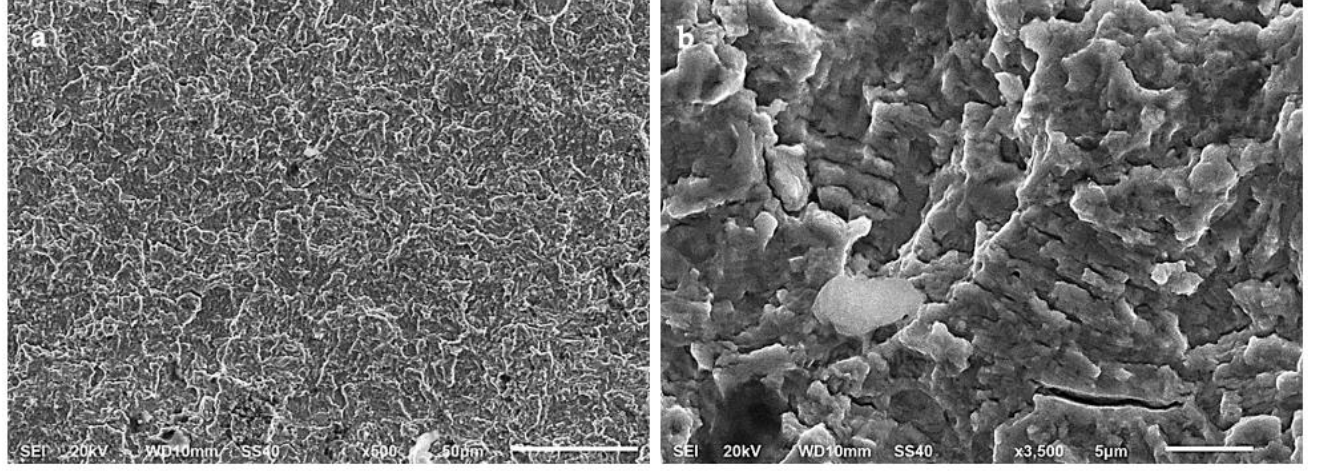
Figure 15. Crack propagation area of a B-type steel specimen tested in air to a maximum stress of 1020 MPa (69% YS) at ( a ) ×500 and ( b ) ×3500.